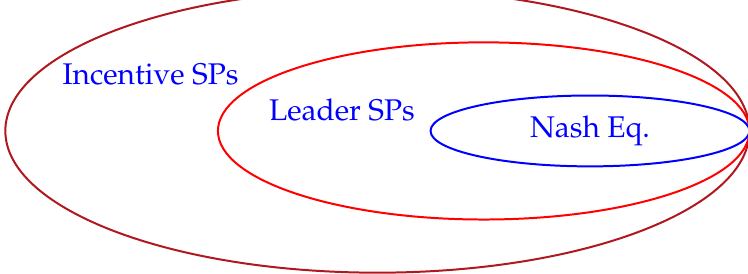
Figure 1. Incentive strategy profiles ⊇ Leader strategy profiles ⊇ Nash